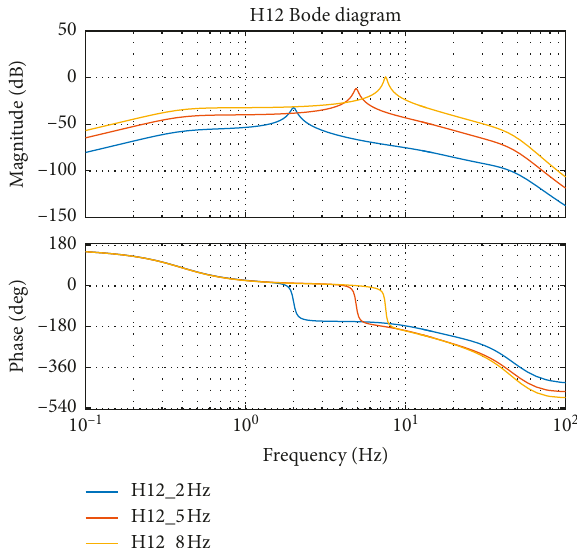
Figure 6: Effect of specimen’s natural frequency on frequency response of H 12